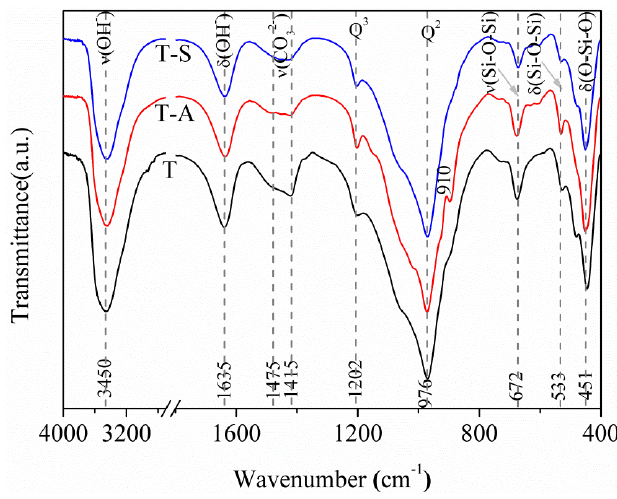
Figure 3. FT-IR spectra of the tobermorite samples.